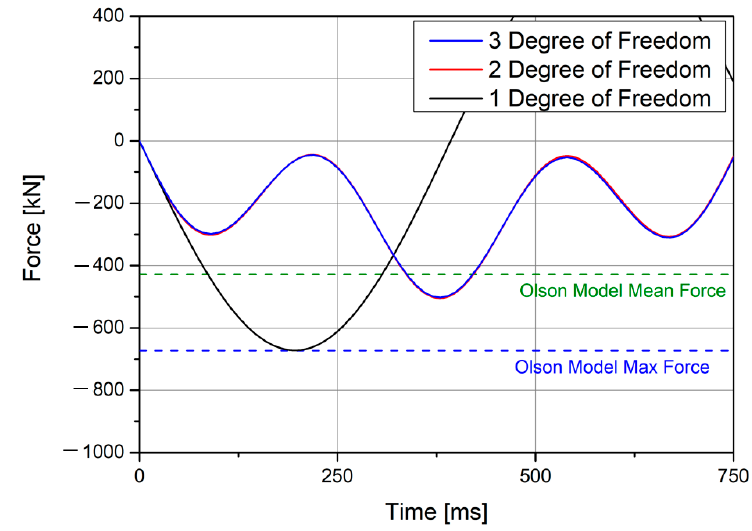
Figure 12. Impact loads considering suspension sti ff nesses.